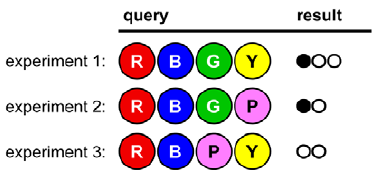
Figure 4. Continuation of the game from Figure 3.